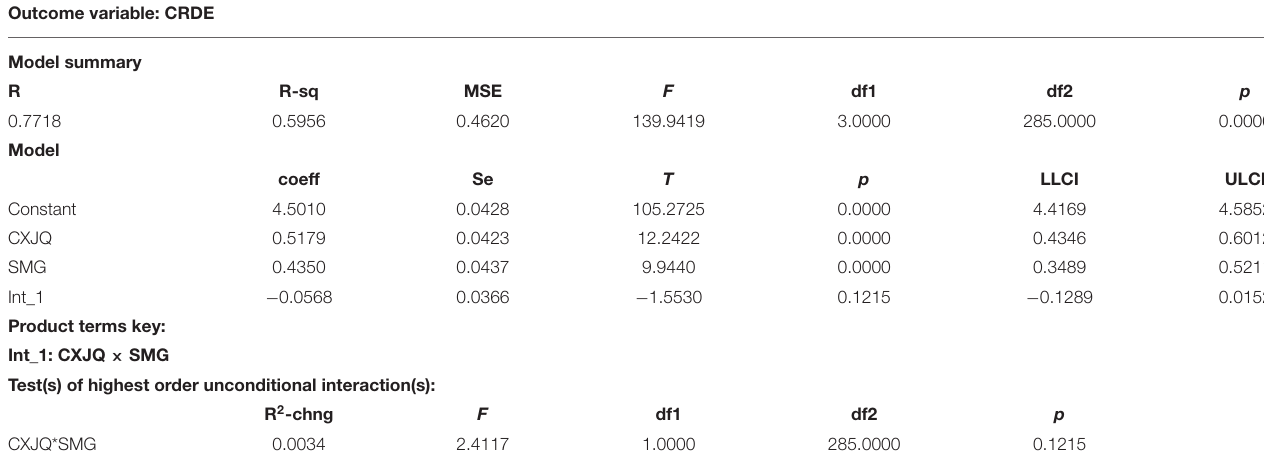
TABLE 14 | Test results of SMG moderating